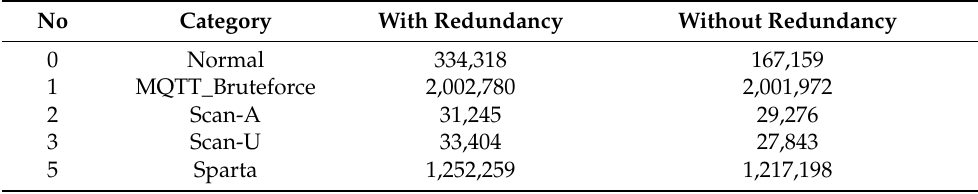
Table 4. MQTT-IoT-IDS2020 dataset